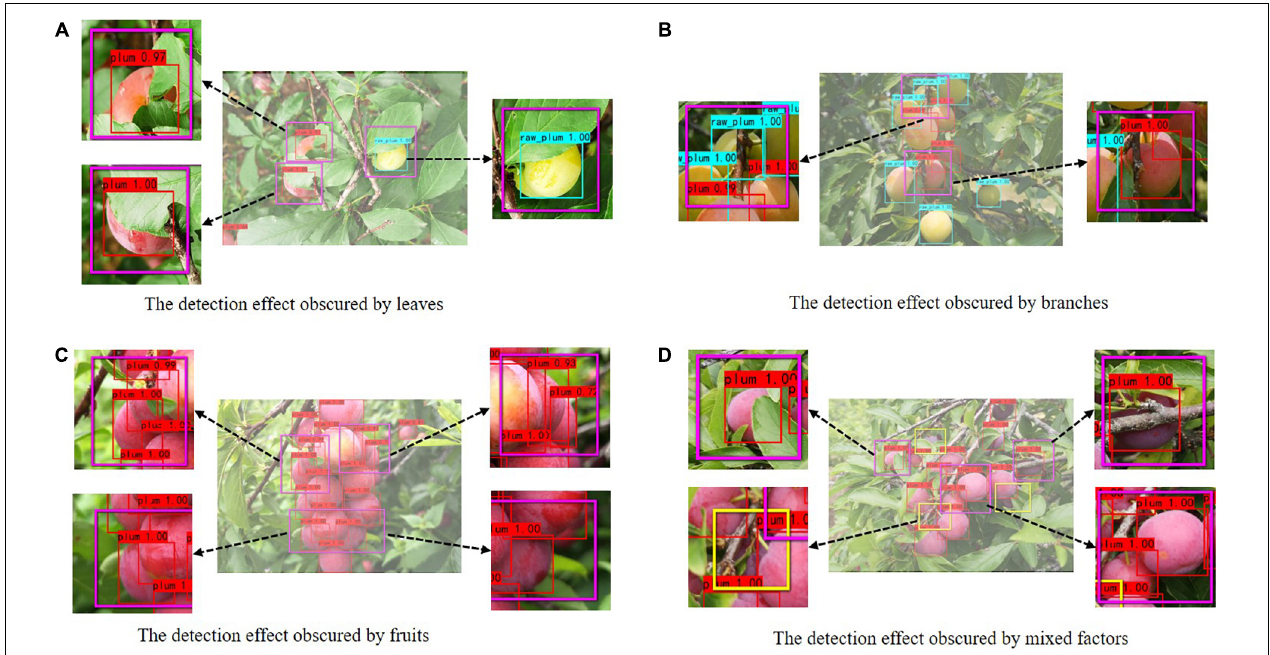
FIGURE 10 | The comparison of plum detection effect under different